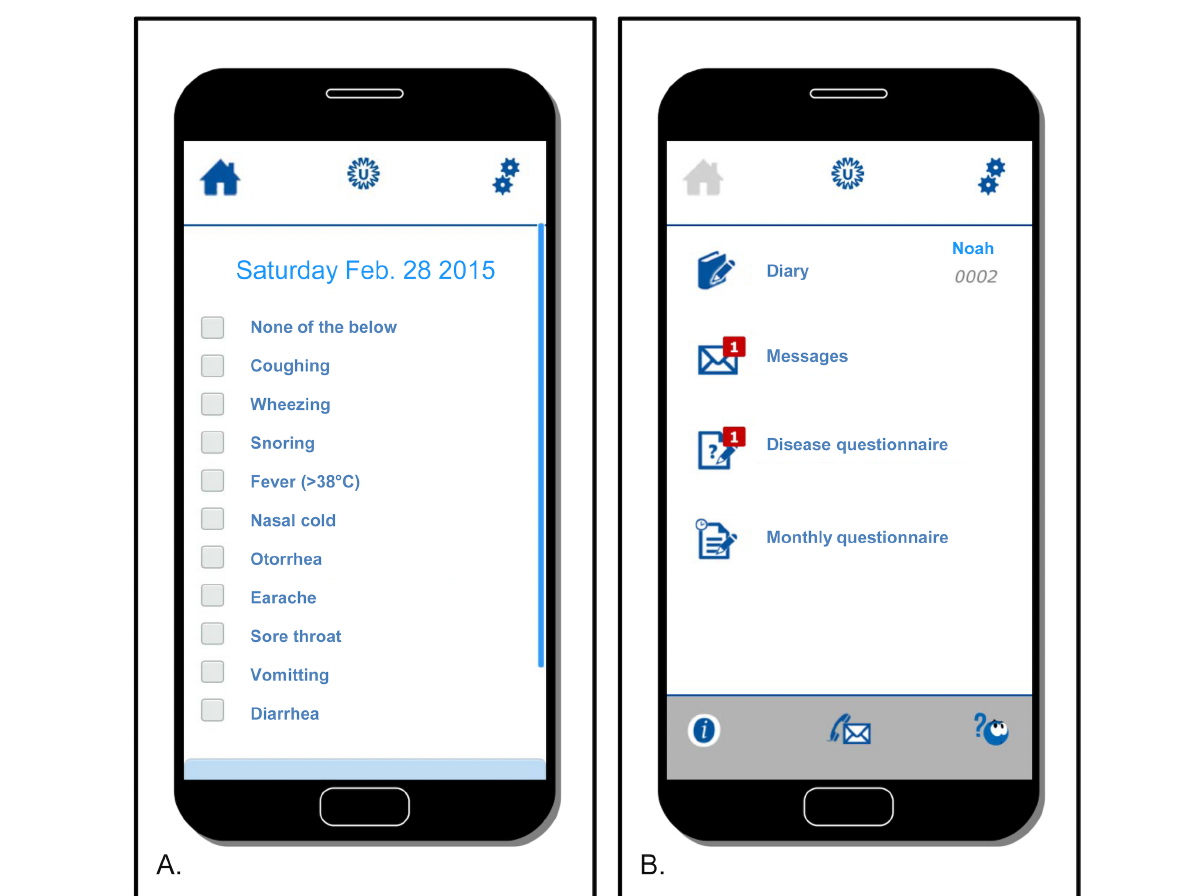
Figure 2. Screenshots of the diary app (InfectieApp) used in the 2015 study period. (A) symptom diary; (B) home